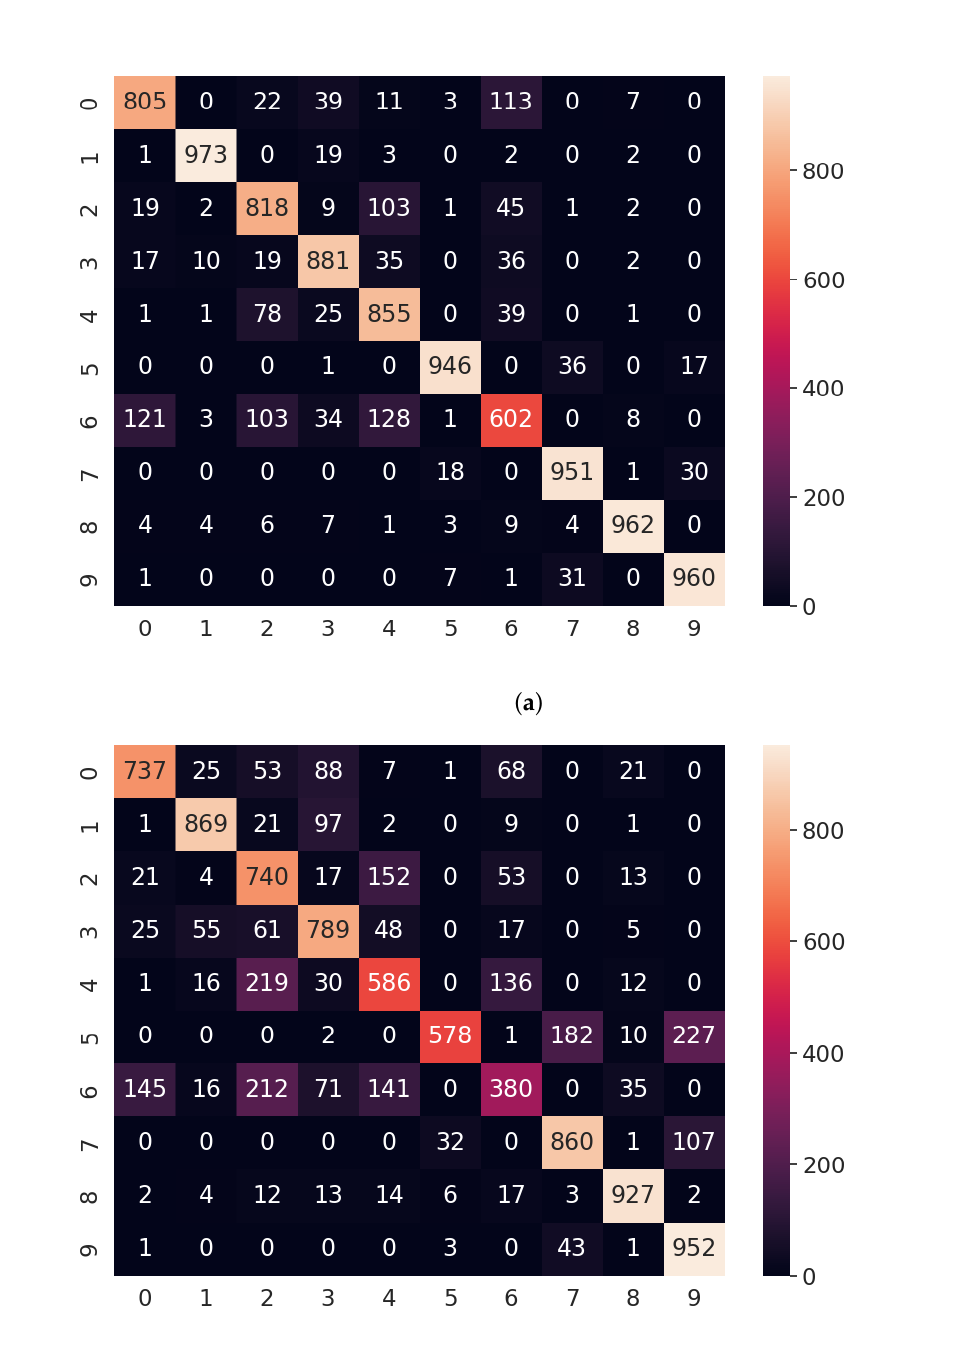
Figure 9. The confusion matrix of a trained architecture on the test set of the Fashion-MNIST dataset in the case of the reference CNN model ( a ) and in the case of our kervolutional neural network model ( b ). As one can see, the two confusion matrices were qualitatively similar, and although there were more misclassifications in the case of the SAW convolver (which was natural since it had a slightly lower accuracy), the distribution of the errors was similar. (The number labels mean the following: 0 = T-shirt, 1 = trouser, 2 = pullover, 3 = dress, 4 = coat, 5 = sandal, 6 = shirt, 7 = sneaker, 8 = bag, and 9 = ankle